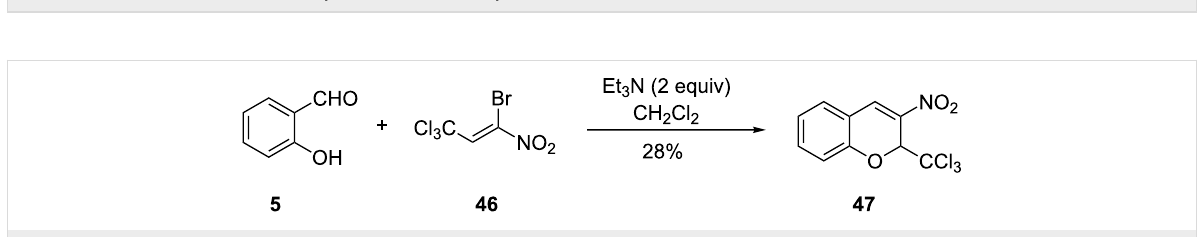
Scheme 17: Kawase and co-workers synthesis of 2,2-dimethylchromene 45 .